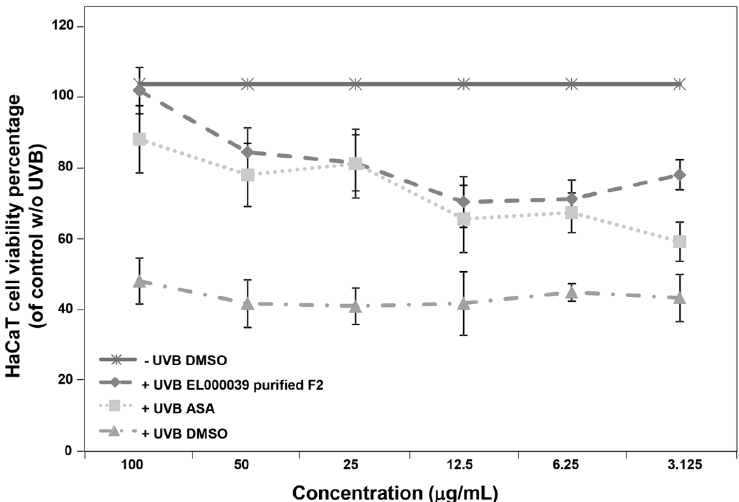
Figure 5. HaCaT cell viability after treatment with ELF000039 purified F2 ((3 R )-5-hydroxymellein) and UVB irradiation. The cell survival without UVB was considered 100%; DMSO was a negative control. Data shown are the means ± SD ( n = 3).